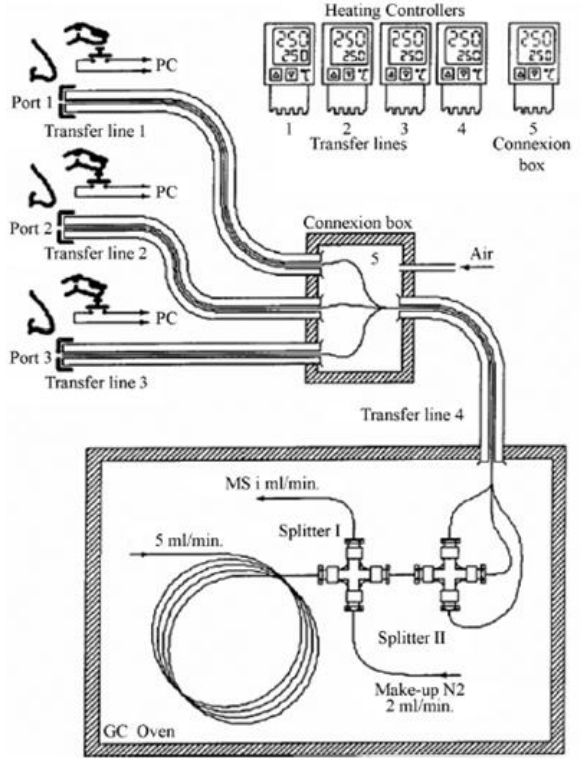
Figure 2. Scheme of the GC/MS-O multi-sniffing system (reprinted from [25] with permission from